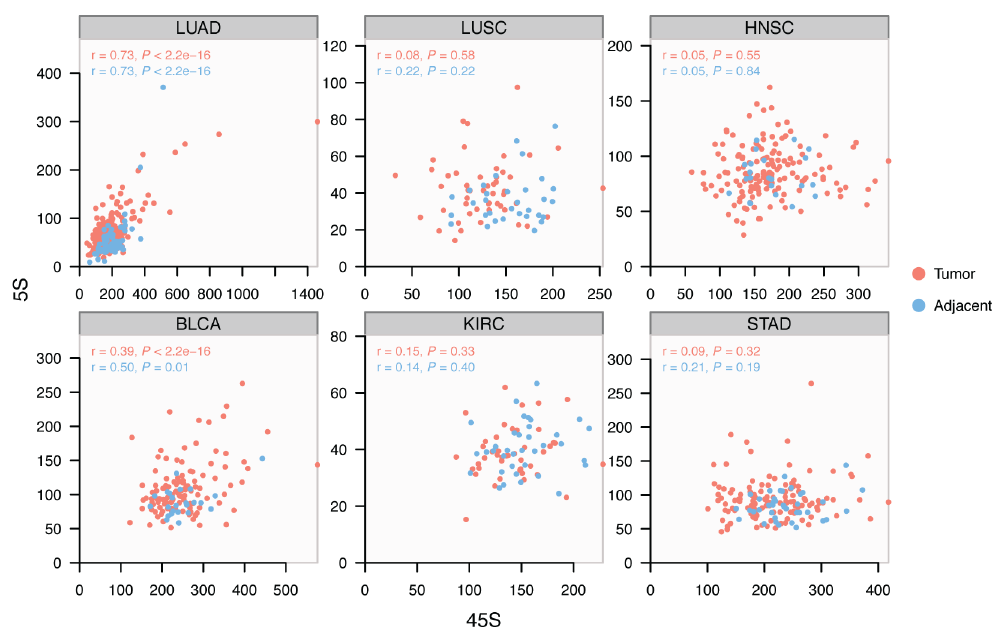
Fig 2. Variable manifestation of concerted copy number variation (cCNV) across tissues. Pearson correlation between the 5S and 45S rDNA arrays is variableamongtissues. The correlationis significantand similarlymanifestedin normaland cancer lineages of LUAD and